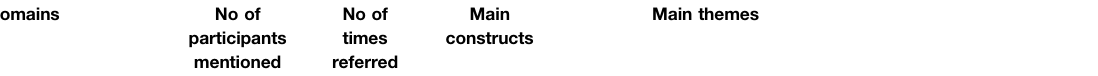
TABLE 4 | ( Continued ) Enablers to patients ’ adherence to the evidence-based guideline recommendations for venous leg ulcer